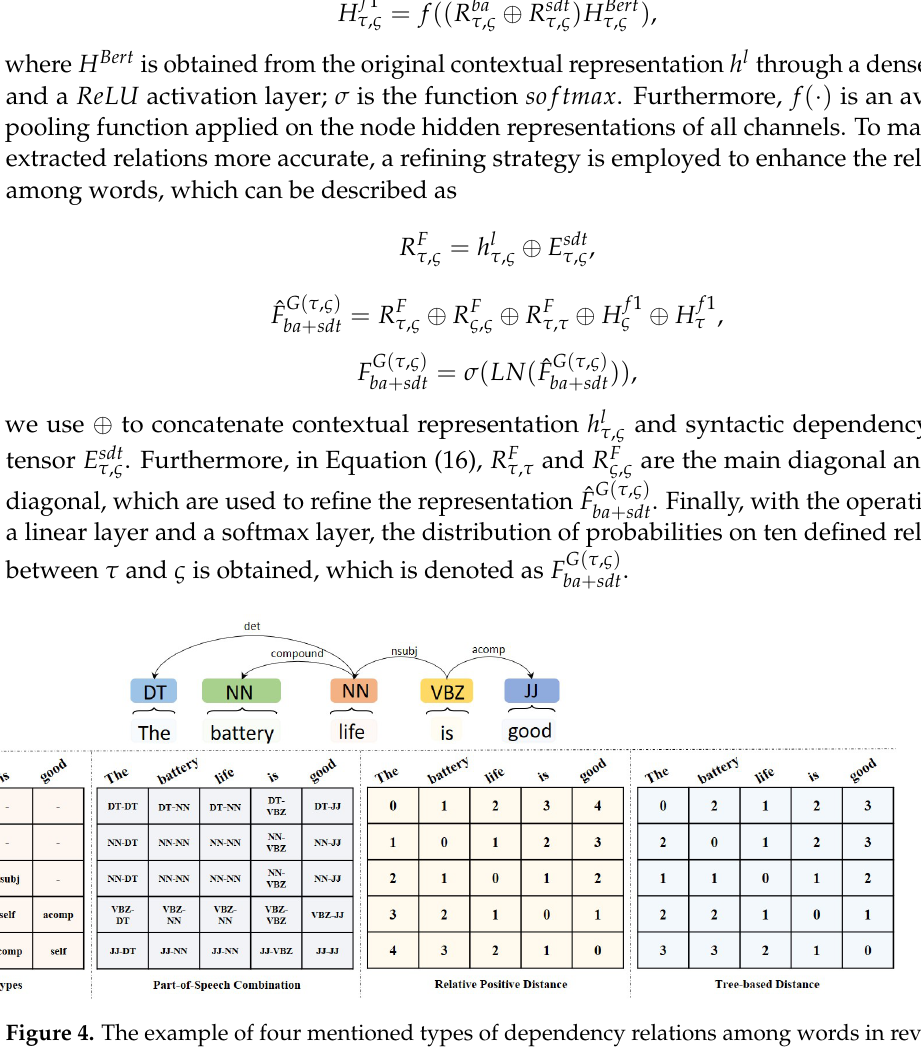
Figure 4. The example of four mentioned types of dependency relations among words in